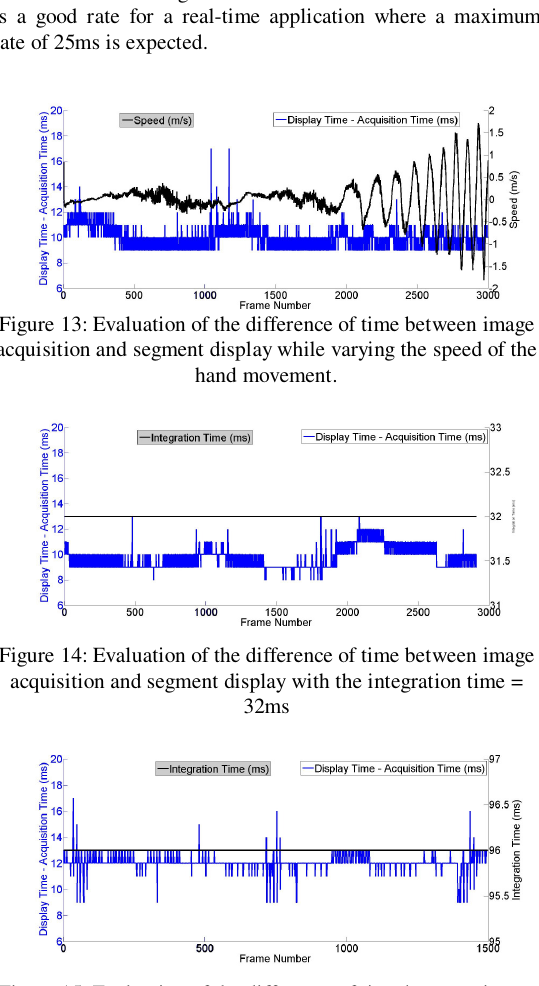
Figure 15: Evaluation of the difference of time between image acquisition and segment display with the integration time = 96ms